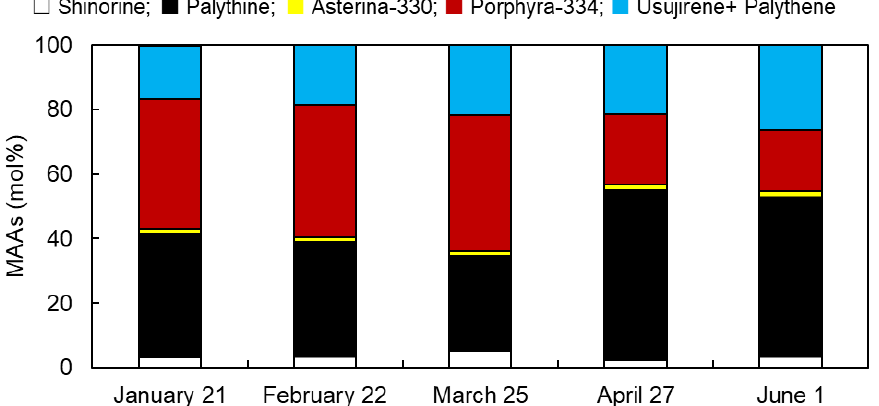
Figure 2. Molar percentages of MAAs in 2021. The content of six MAAs—shinorine, palythine, asterina-330, porphyra-334, and usujirene + palythene—in dulse collected on 21 January, 22 February, 25 March, 27 April, and 1 June. Data show mean values, n = 3.